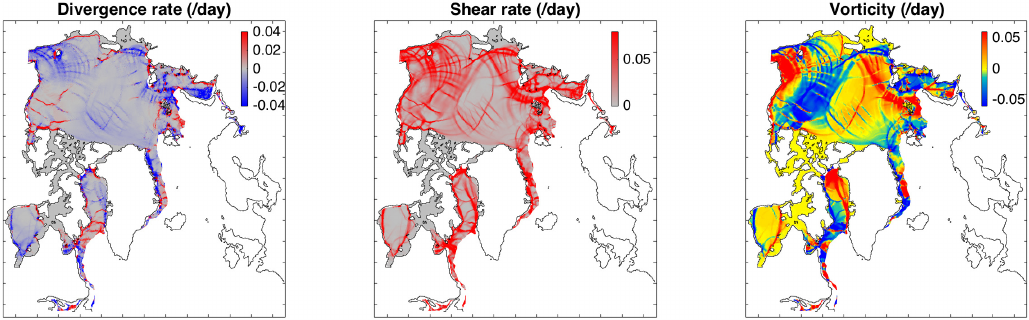
Figure 9. Example of deformation fields simulated by neXtSIM. The divergence rate, shear rate, and vorticity are computed from the Lagrangian displacement simulated between 20 and 21 February 2008. One could note that a large divergence rate coincides with a large shear rate and that landfast ice is present on the Siberian coast and east of Kara Sea.